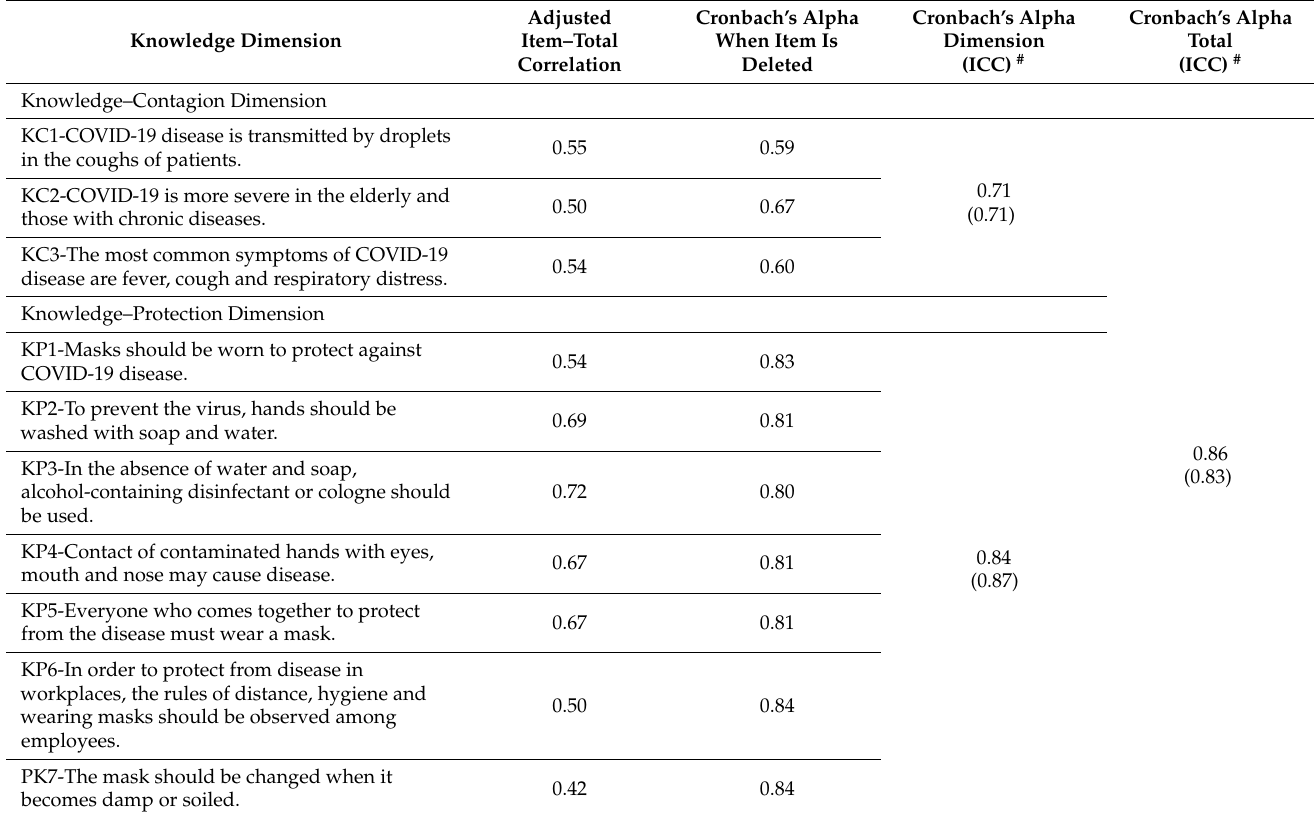
Table 1. Knowledge dimension reliability